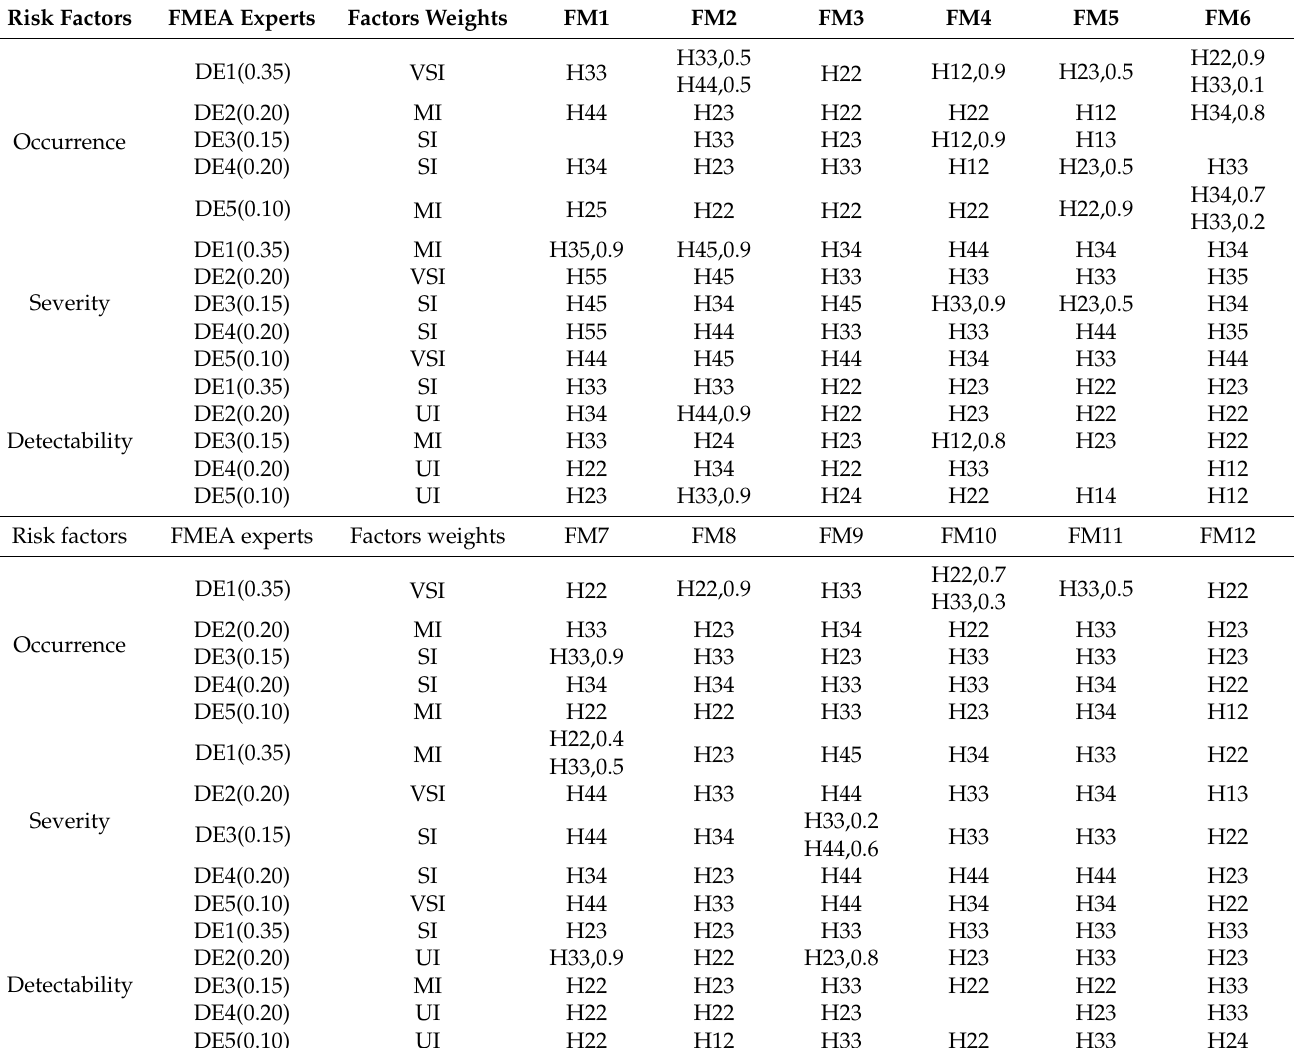
Table 7. Assessment information on 12 failure modes by five FMEA experts.